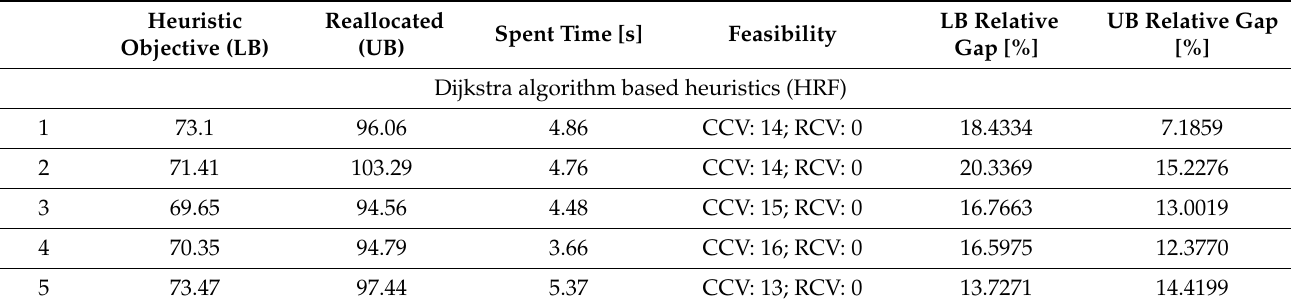
Figure 7. Dual function value during simple subgradient level method coordination algorithm iterations. Continuous and binary variables decomposition for P alt , medium problem, instance 1. Table 7. Numerical results for medium problems—Dijkstra algorithm based heuristics